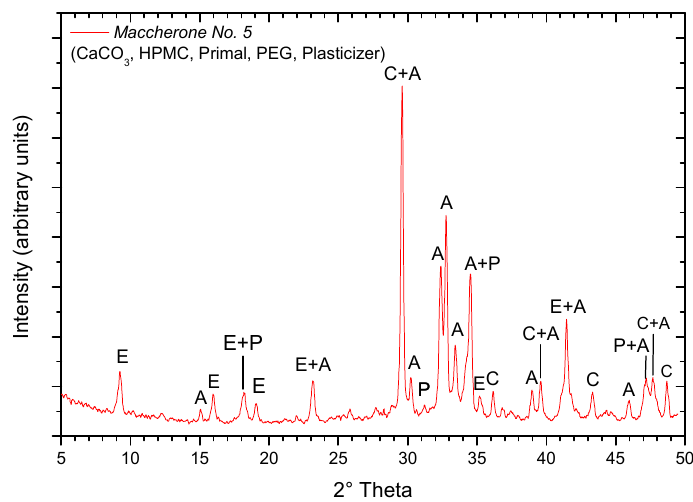
Figure 9. XRD pattern of the extruded maccherone hollow tube (Recipe No. 5). C, calcite (CaCO 3 , JCPDS 72-1650); E, ettringite (Ca 6 Al 2 (SO 4 ) 3 (OH) 12 .26H 2 O, JCPDS 31-0251); P, portlandite (Ca(OH) 2 , JCPDS 04-0733); A, alite (3CaO.SiO 2 , JCPDS 31-0297).